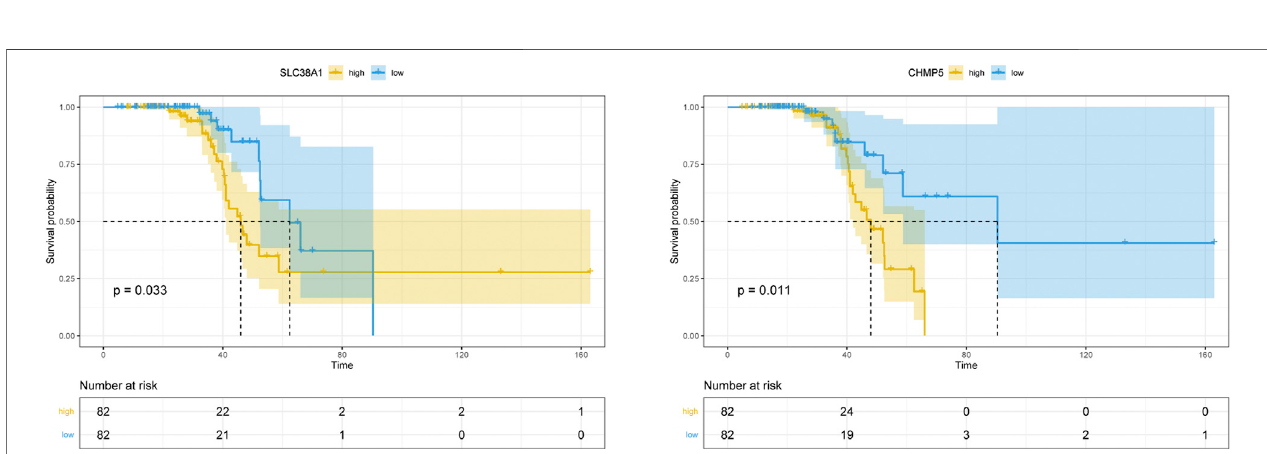
Frontiers in Genetics |